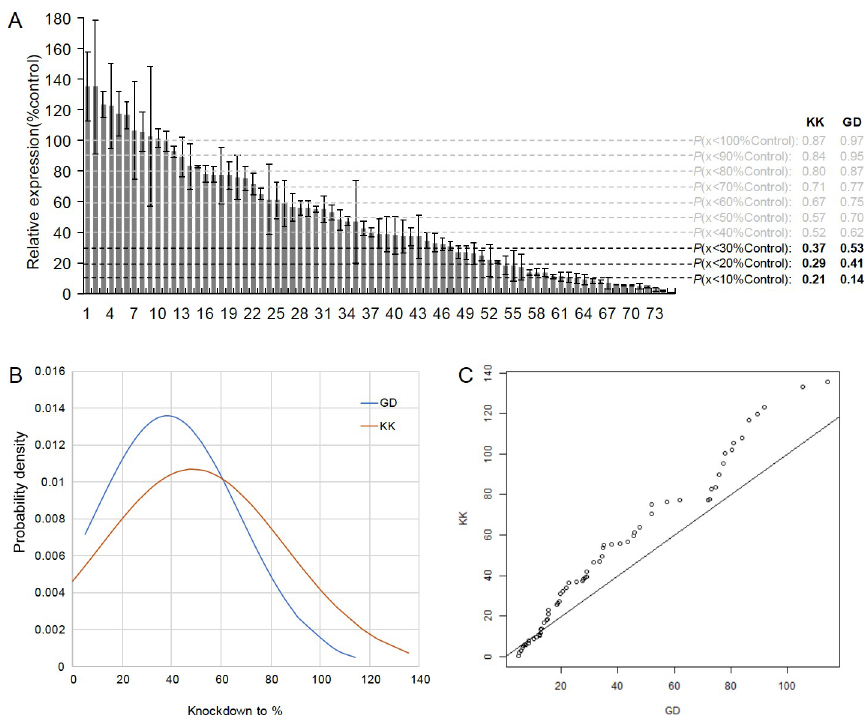
Fig 2. Knockdown efficiency in the KK and GD libraries revealed GD lines have significantly higher knockdown efficiency than the KK lines. A. The knockdown efficiency of the 75 KK lines was measured, compared to the expression of the wild-type control and the standard deviation is calculated from the measurement of three repeats; P refers to proportion of genes with the expression lower than a certain threshold while the values of KK lines are generated in this work and that of GD lines are extracted from [29]. B. The Z-score distributions of knockdown efficiency of KK and GD lines. z-score means the number of standard deviations from the mean. z = (x– μ )/ σ , x is the value to be standardized, μ is the mean, σ is the standard deviation. 38.1% and 48.6% are average knockdown-to- percent of GD and KK lines, respectively. C. The Q-Q Plot (quantile-quantile plot) between KK and GD lines. Q-Q plot is a probability plot which is used here for comparing probability distributions between knockdown-to-percent of KK and GD lines by plotting their quantiles against each other. Those Q-Q plots don’t fit the best fitting straight line, which indicate that the knockdown efficiency distribution between KK and GD lines are